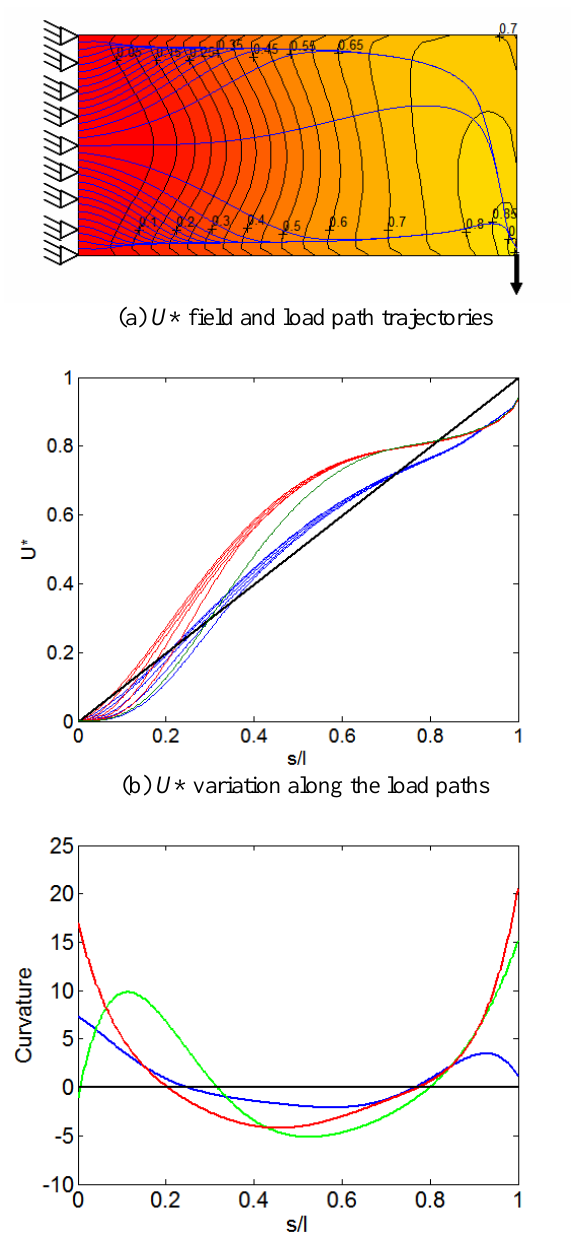
Fig. 15. Transferred and potential transferred force to